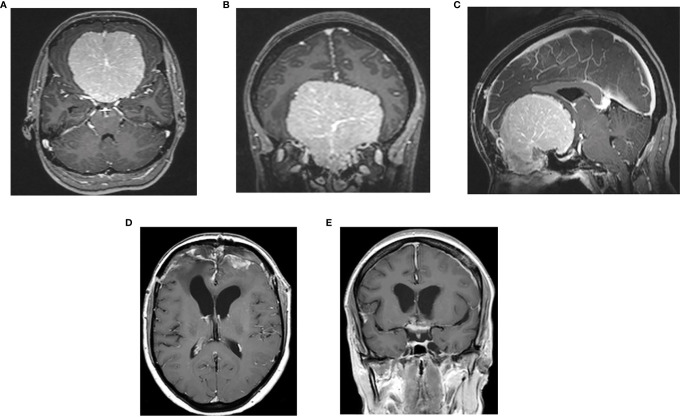
Preoperative post-contrast MRI, axial (A), coronal (B) and sagittal (C) sequences of 30- year-old female with giant meningioma of spheno-ethmoidal planum presenting with bilateral visual deficit at 30th week of pregnancy; postoperative postcontrast axial (D) and coronal (E) sequences: complete tumor removal.